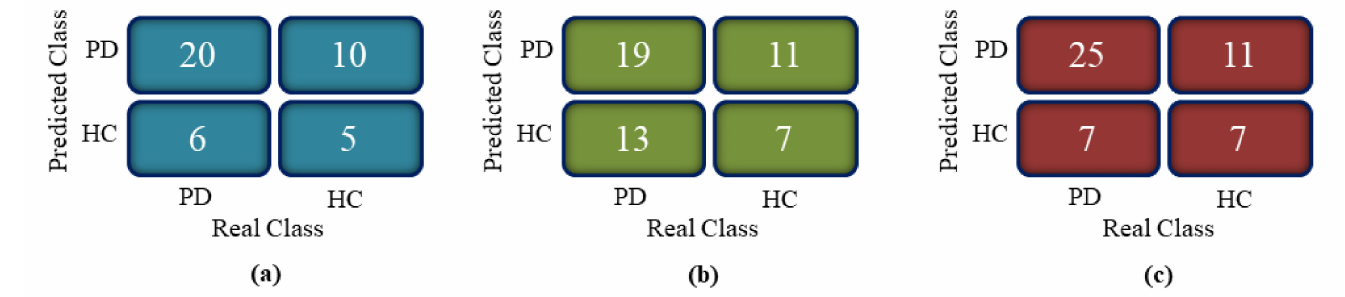
Figure 8. Confusion matrix of clustering algorithms: ( a ) DBSCAN, ( b ) K-means and ( c ) Hierarchi- cal Clustering.